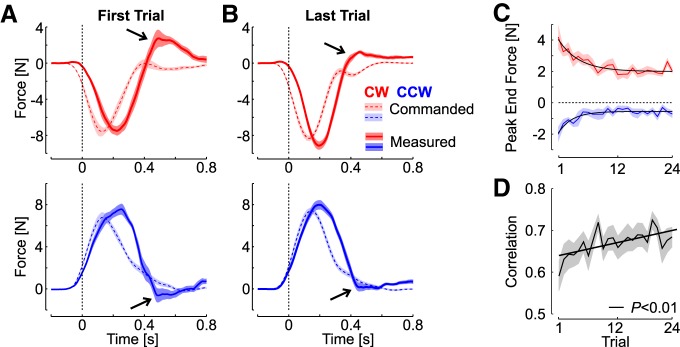
Improvement in online corrections. A, Lateral perturbation force (dashed/light) and measured force (solid/dark) as a function of time for the first FF trial in each direction. B, Same as panel a for the last perturbation trial. Shaded areas represent 1 SEM across participants (n = 14) with the same color code as in Figure 1. Note that each FF induced a reaction force with opposite sign, thus the perturbation force was multiplied by –1 for illustration. The reduction in peak end force is highlighted with the black arrows. C, Peak end force across FF trials (mean ± SEM). The solid traces show the significant exponential decay (p < 0.005). D, Correlation between the commanded force and the measured force during the time interval corresponding to the gray rectangle in panel A (100–700 ms). The correlations were averaged across participants; the shaded area represents 1 SEM. The significant linear regression of the correlations across blocks is illustrated.